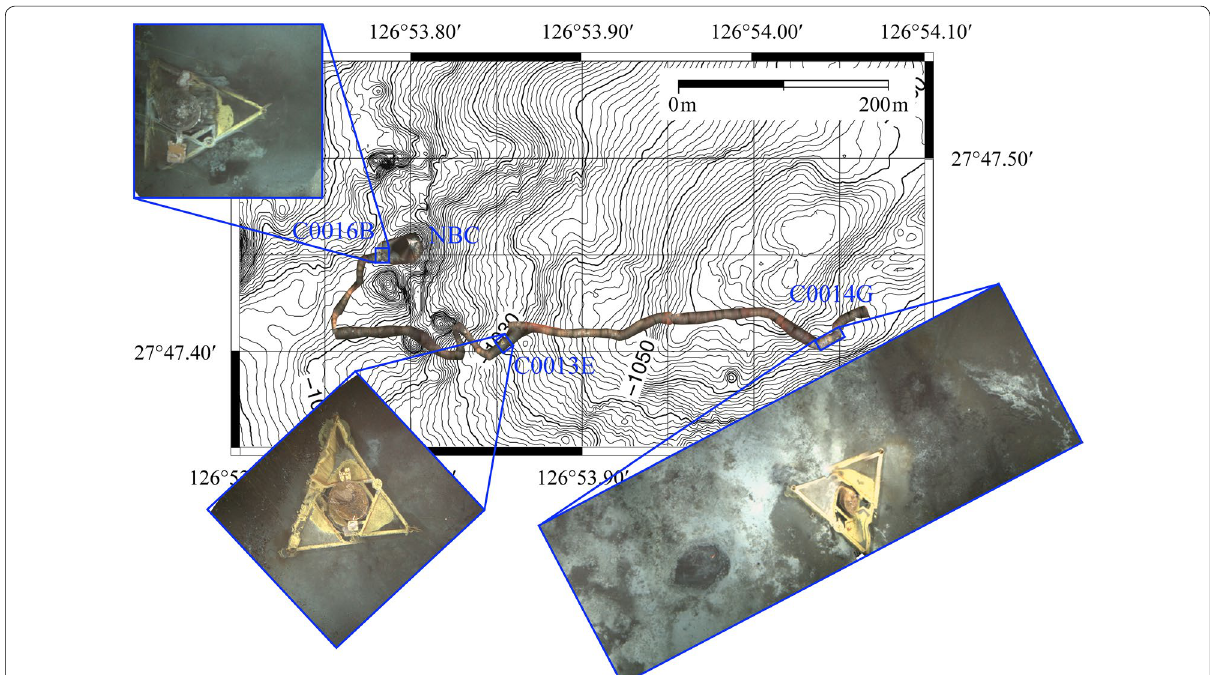
Fig. 4 3D map generated from data collected by the SeaXerocks 2 mapping system in 1 h, overlaid on the depth map of dive site. While all the data was recorded in high resolution, three areas of interest, which are the artificial hydrothermal chimneys, are shown enlarged